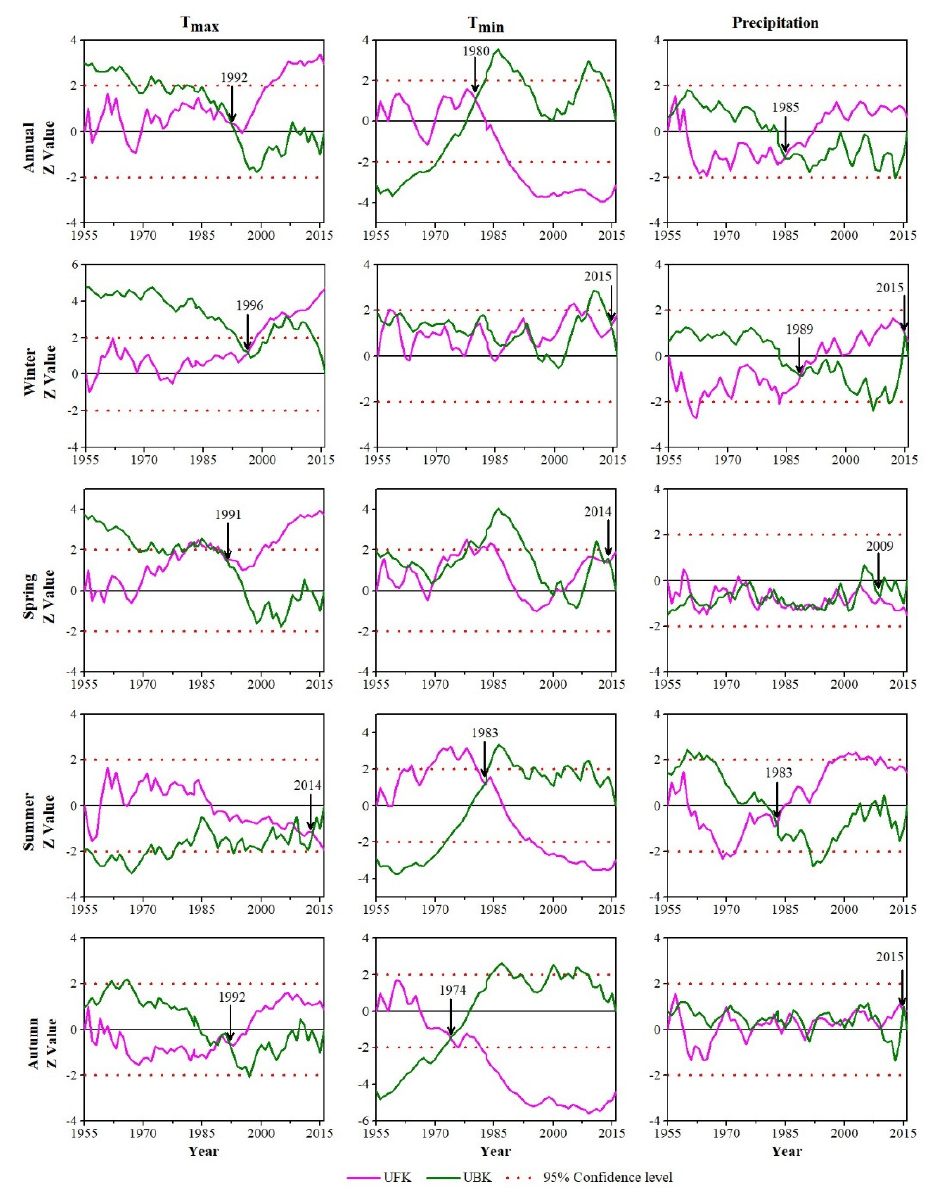
Figure 6. Start of trend, abrupt change and significant trend as determined by sequential Mann-Kendall test for annual and seasonal T max , T min and precipitation in the UIB during 1955–2016.